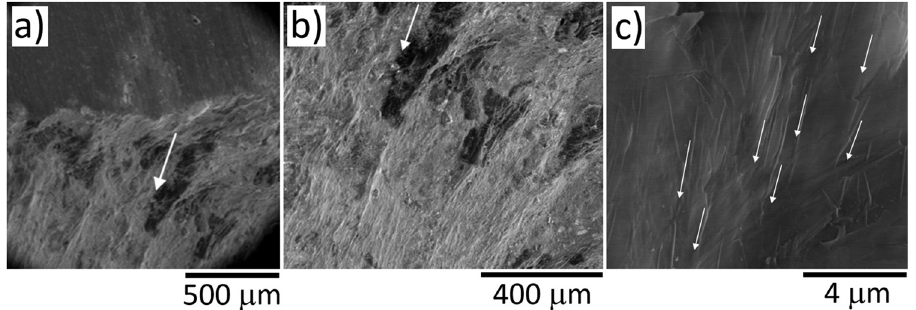
Figure 8: Representative SEM images of the extruded HA monolith at di ff erent magni fi cations ( a ) , ( b ) and ( c ) . The images were acquired inside a pore in the extrusion zone with an RD of 96%. Arrows indicate the direction of HA fl ow during